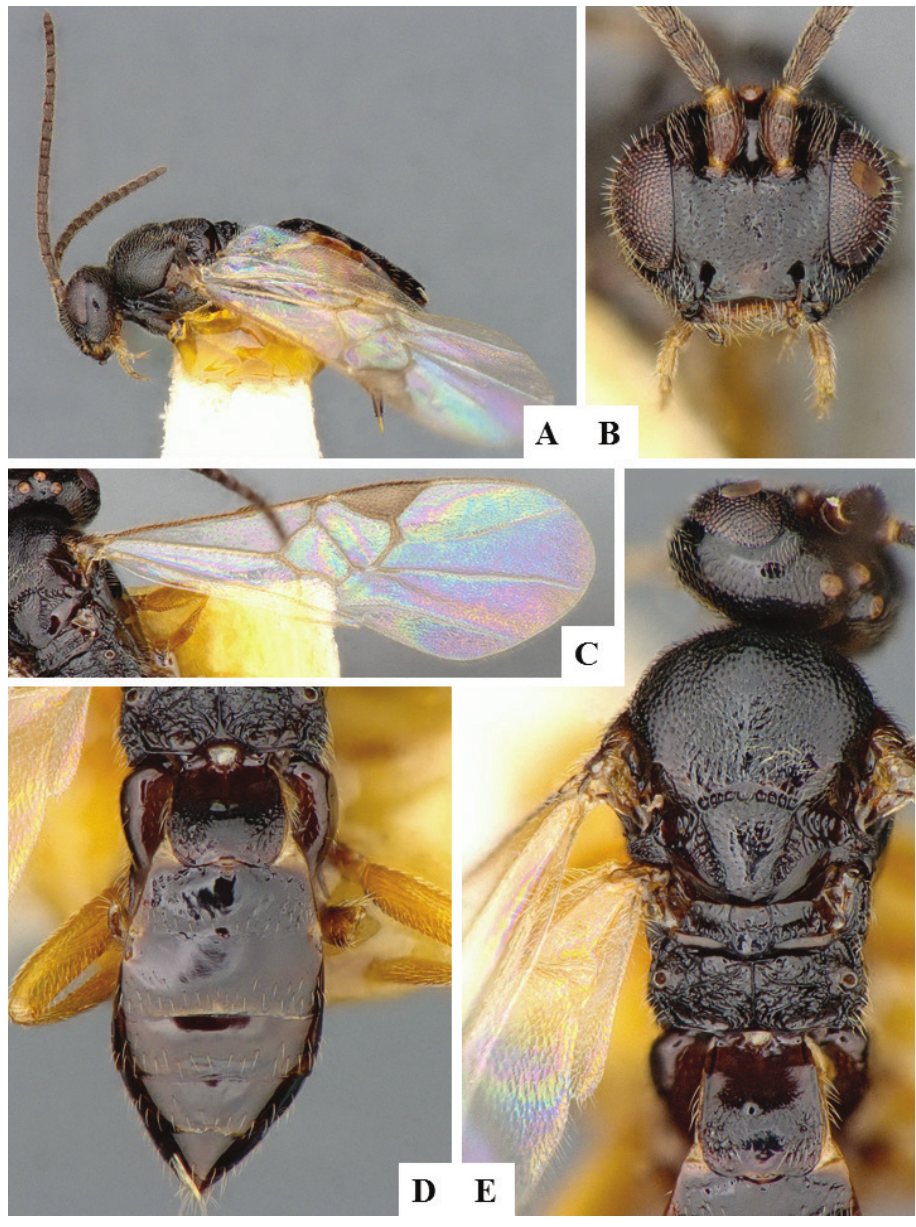
Figure 15. Cotesia atalantae. A Habitus, lateral B Head, frontal C Wings D Metasoma, dorsal E Head and mesosoma,